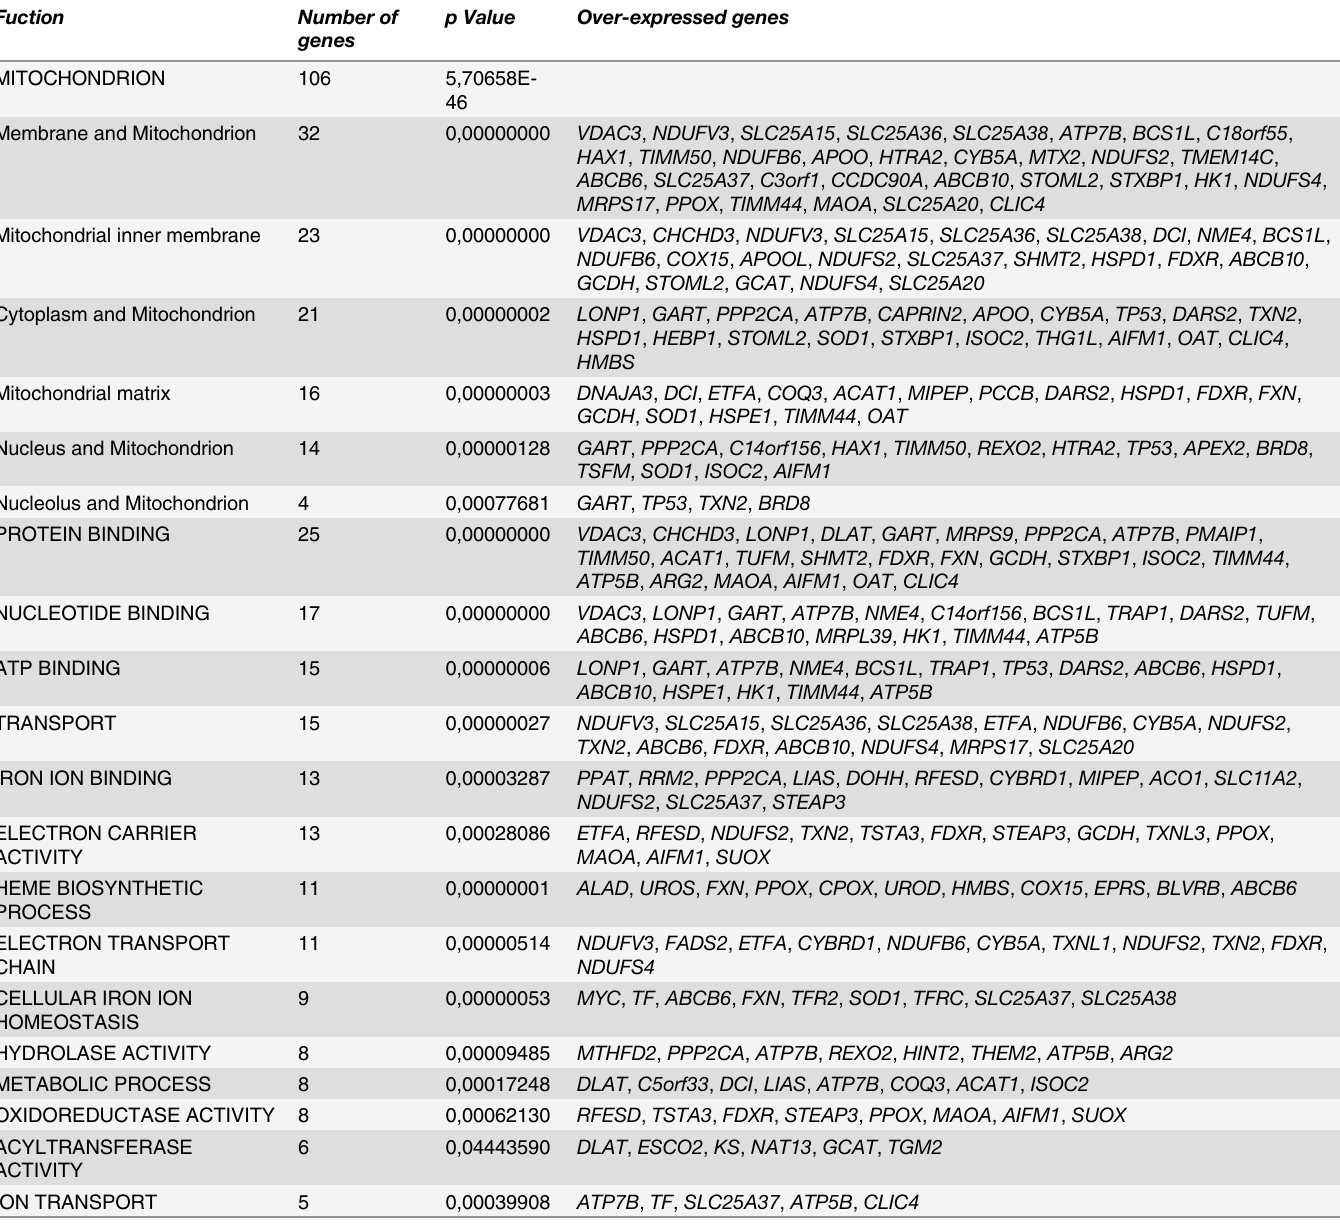
Table 1. Most representative deregulated cellular functions in RARS patients respect to the control